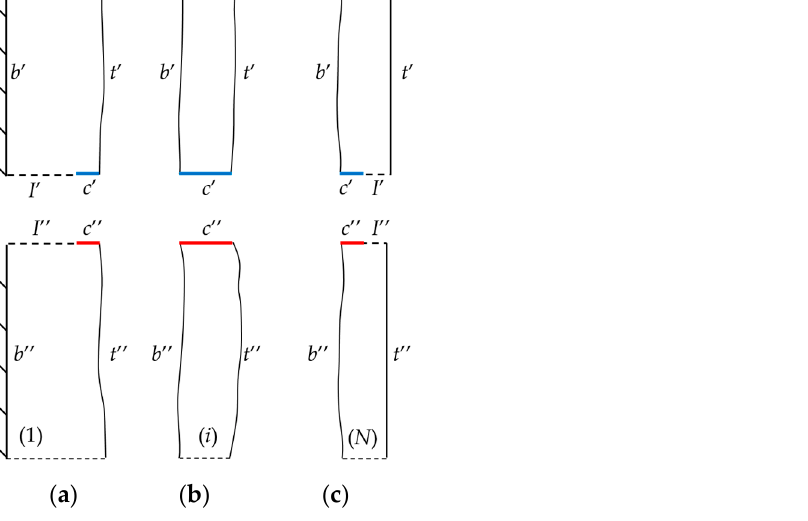
Figure 3. Different boundaries of ( a ) the bottom layer; ( b ) inner layer; and ( c ) the top layer. (1) For the bottom layer ( i = 1):